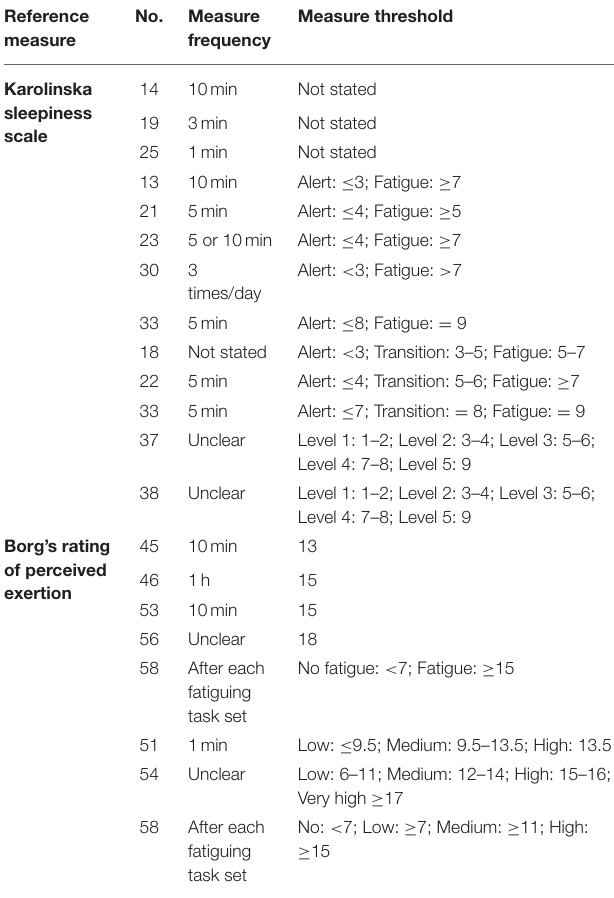
TABLE 8 | Subjective scales used in the different studies: measurement frequency and fatigue thresholds. Reference